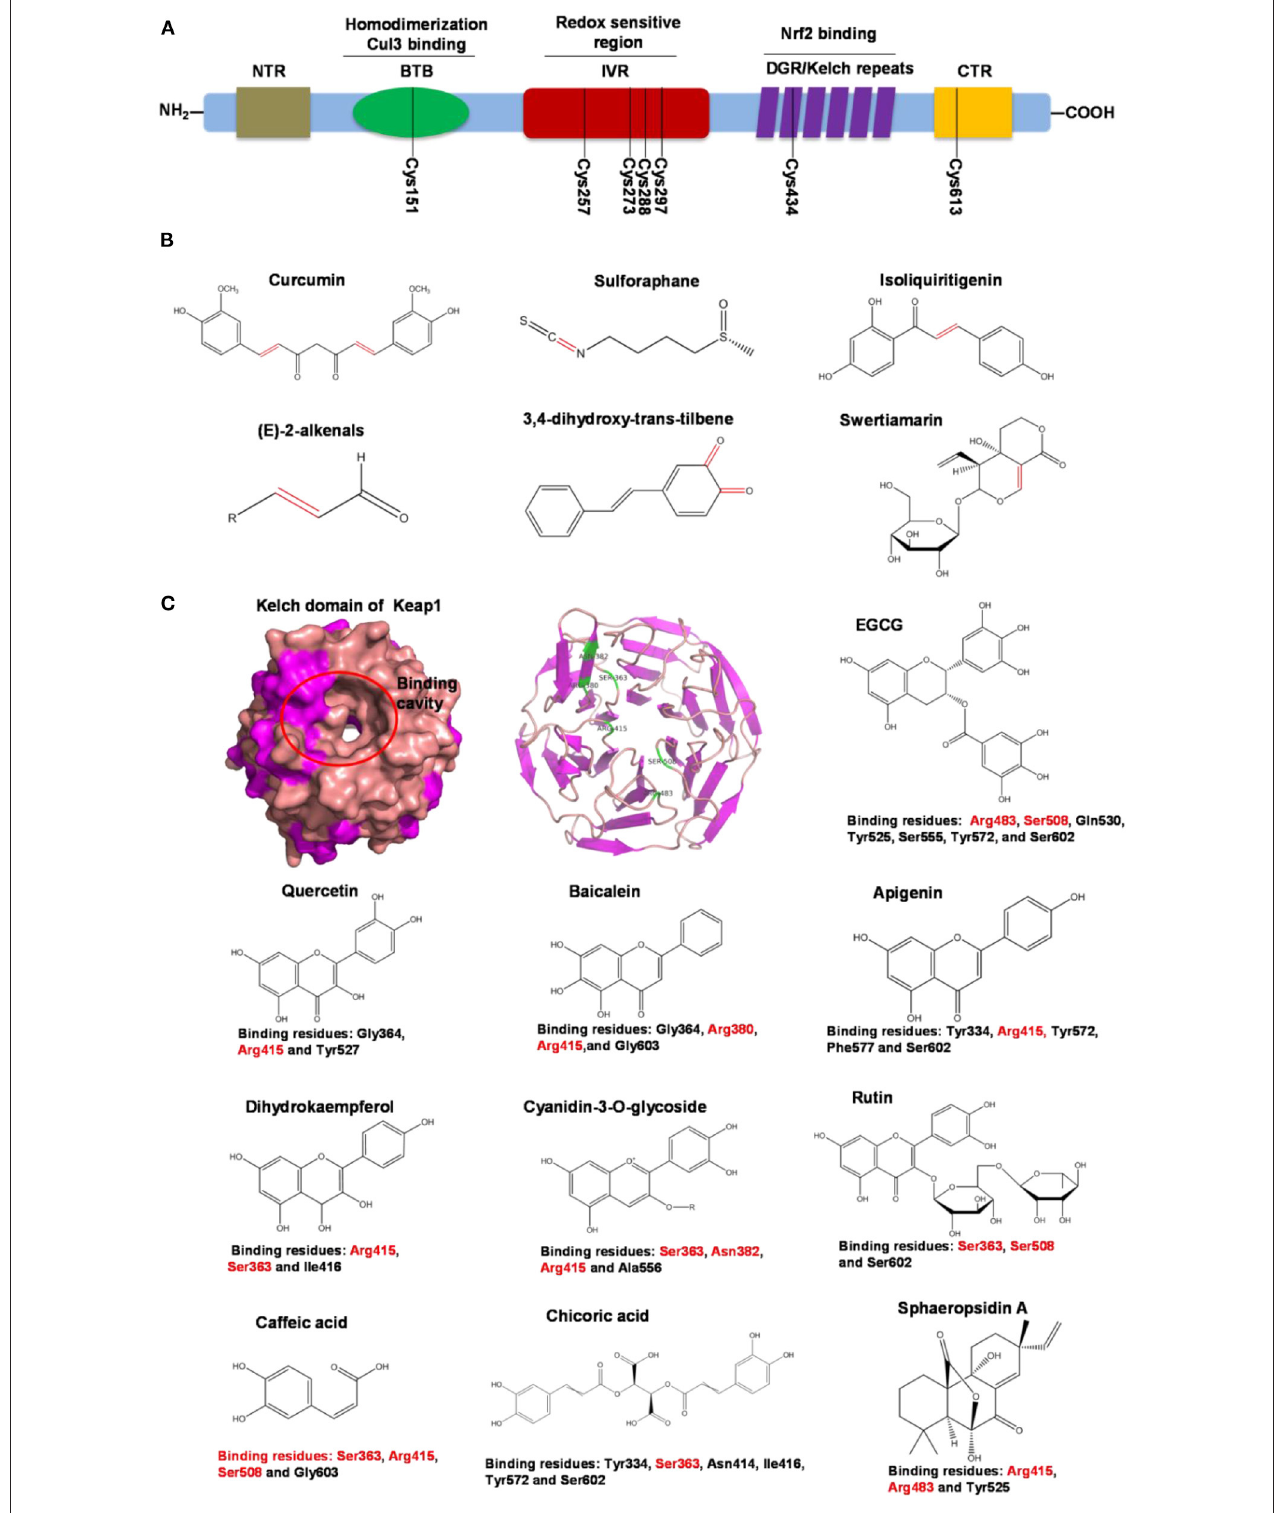
FIGURE 4 | Summary of Keap1 protein structure and binding to phytochemicals. (A) Domain structures of Keap1 protein. Seven cysteine residues (Cys151, Cys257, Cys273, Cys288, Cys297, Cys434, and Cys613) are responsible for covalent binding with phytochemicals to activate Nrf2. (B) Phytochemicals with α , β